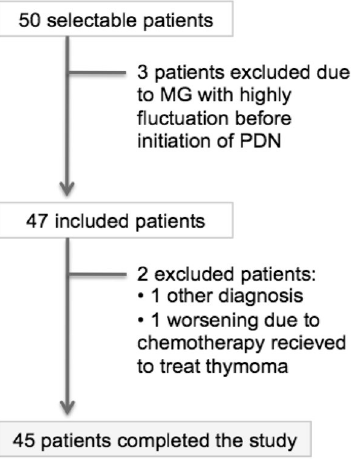
Figure 2. Diagram showing the patients included in the